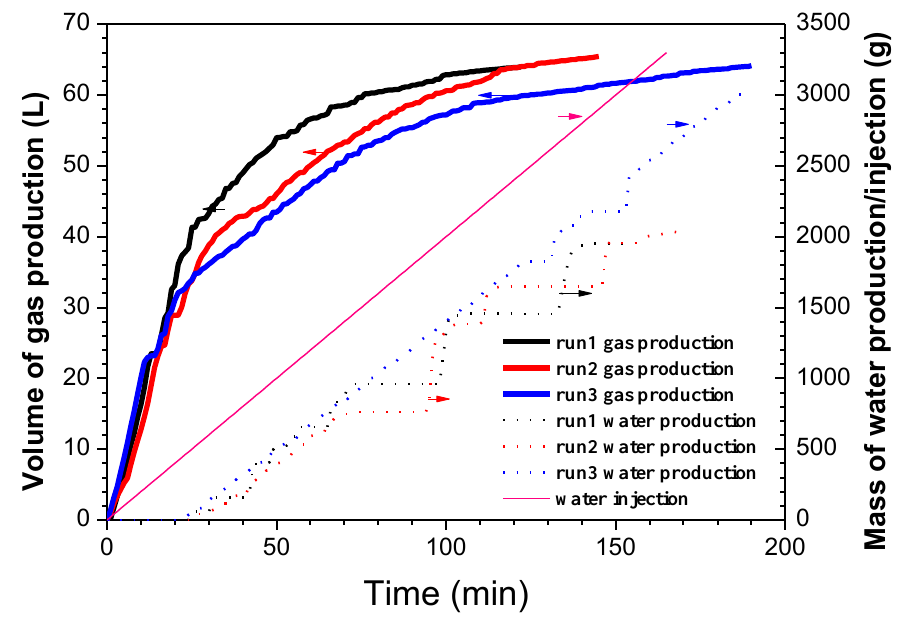
Figure 4. Changes in the volumes of gas production and water injection / production during hydrate dissociation in sediments with di ff erent practical sizes.